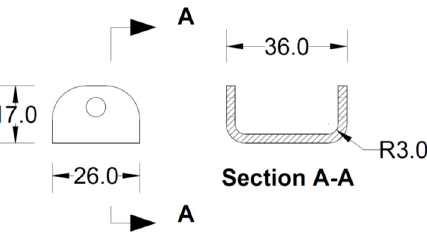
Figure 12. Details of secondary lock channel (all dimensions are in mm, steel plate gauge 12).